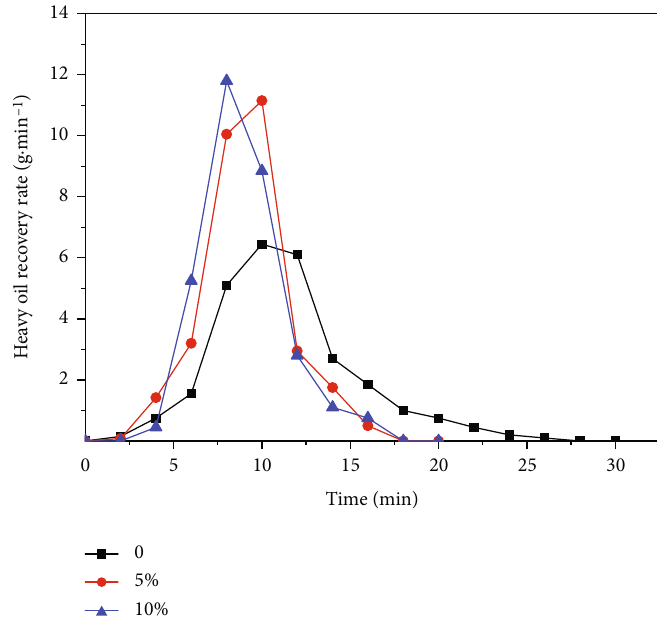
Figure 11: The experimental heavy oil recovery rate curves of each